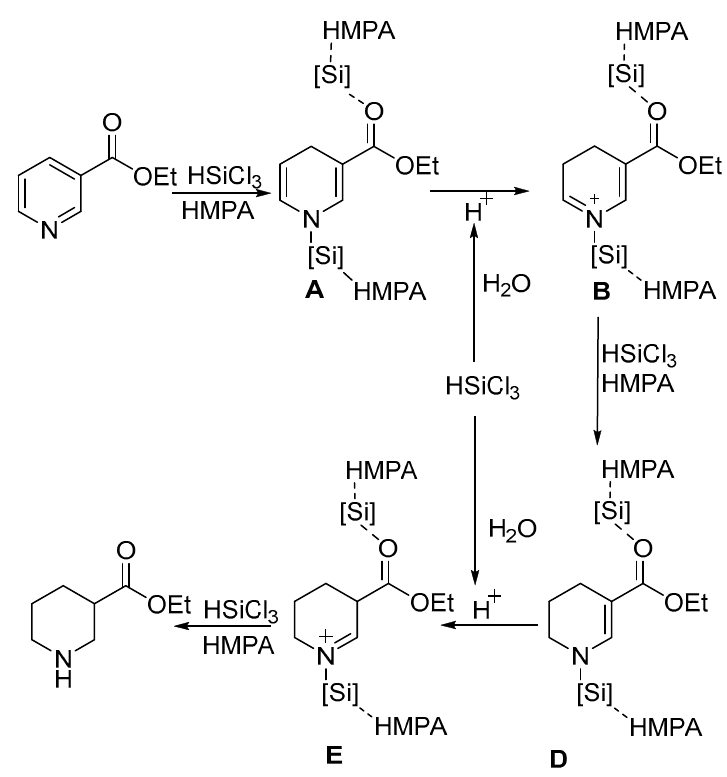
Figure 5. Proposed mechanism of HMPA-catalyzed reduction of ethyl nicotinate with HSiCl 3 .